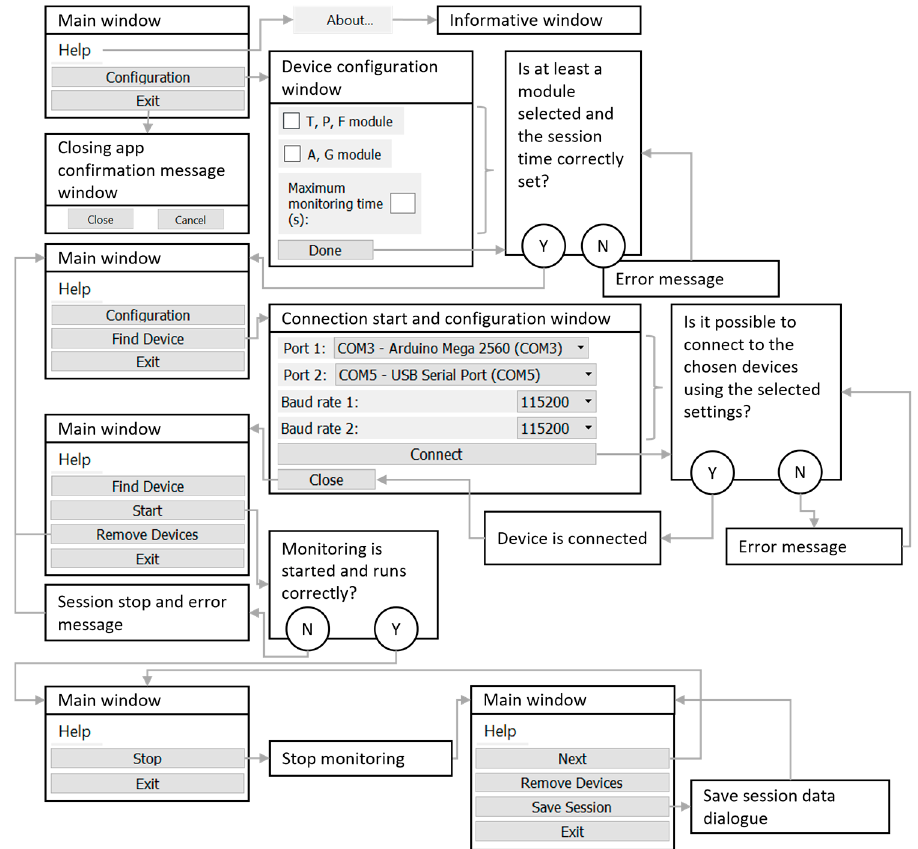
Figure 3. Schematic representation of the GUI, with the available clickable buttons at each operation state and window, as well as the window and operation states that are triggered by clicking each button.